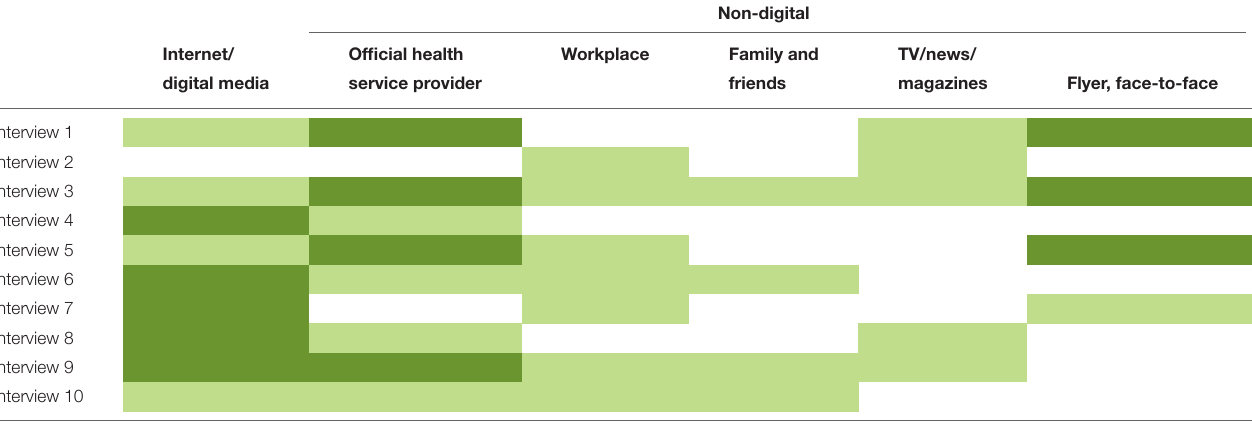
TABLE 2 | Sources of health information used as well as preferred by the qualitative interview participants.